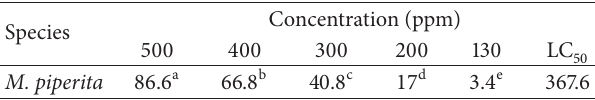
Table 6: Mortality percentage and lethal concentration (LC 50 ) of M. piperita essential oil front Aedes aegypti